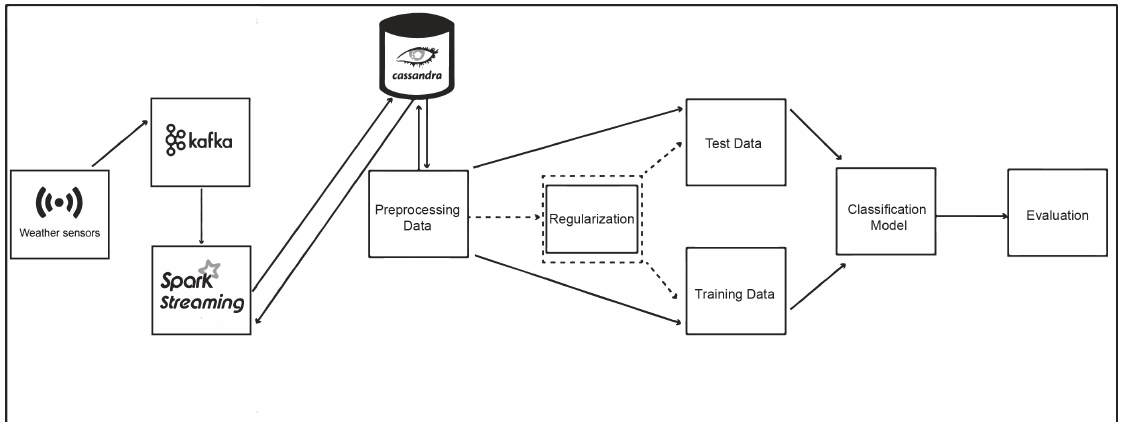
Figure 1. Overall architecture of the proposed